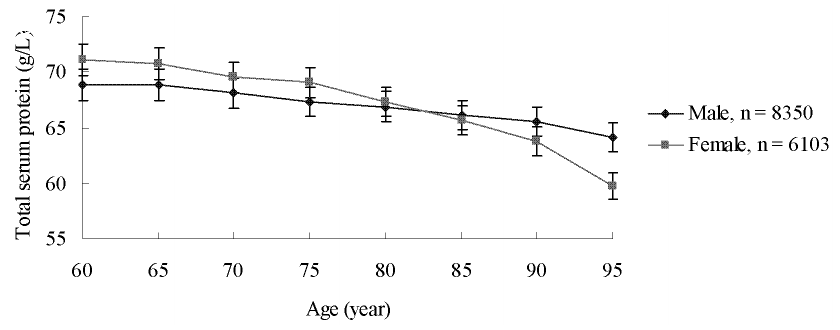
Figure 2. Effect of age on total protein levels in different gender groups aged $ 60.